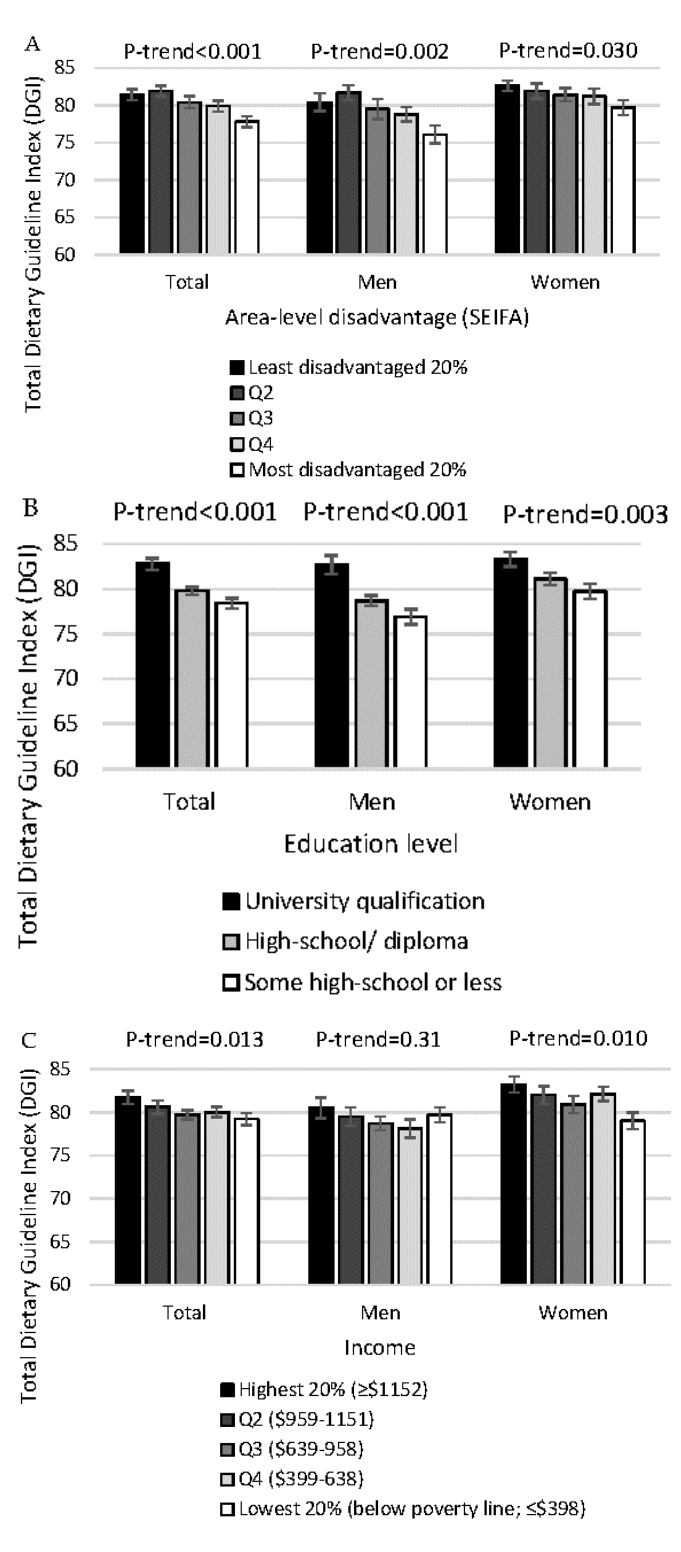
Figure 1. Dietary Guideline Index (DGI) in men ( n = 2356) and women ( n = 2519) from the 2011-13 Australian National Nutrition and Physical Activity Survey by: ( A ) area-level disadvantage; ( B ) education; and, ( C ) income. Area-level disadvantage was assessed using SEIFA (Socio-Economic Index for Areas); Q, quintile; DGI scores could range between 0 and 130. Values represent predictive margins and SE.